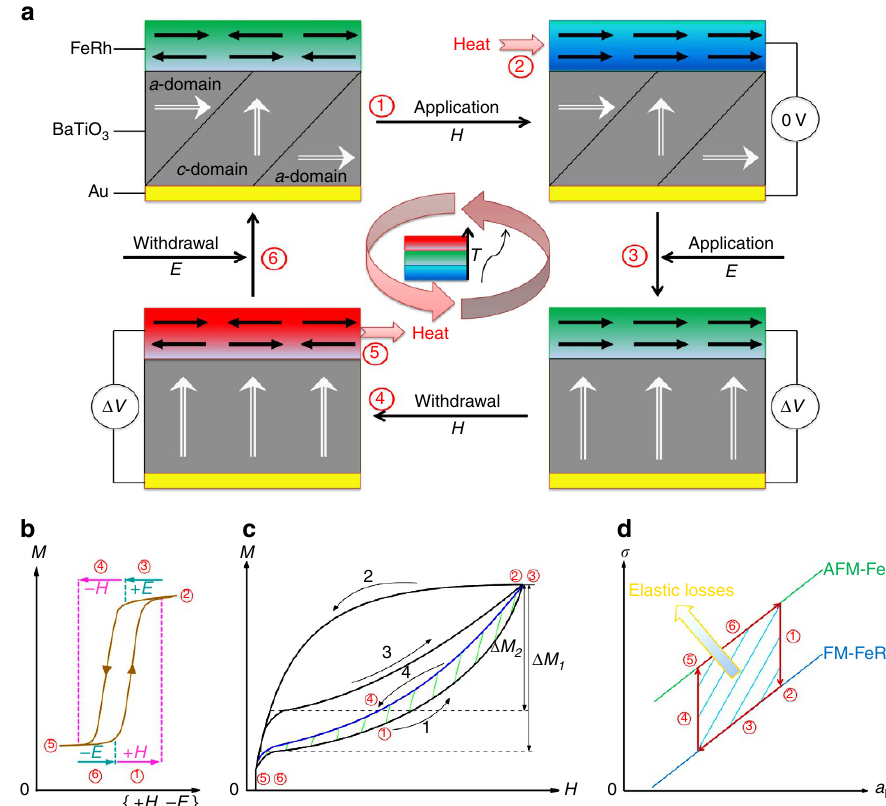
Figure 1 | Multicaloric refrigeration cycle. ( a ) Schematic of a dual-stimulus multicaloric refrigeration cycle. ( b ) Schematic of the effect of electric and magnetic fields ( E , H ) on the magnetization M of FeRh. The electric field overcomes the hysteresis, but does not itself cause M to change. ( c ) Schematic of magnetic cycles, in the space of magnetization M versus magnetic field H . The blue curve denotes a path followed in the presence of the electric field. Black uncircled numbers refer to measurement paths described in the main text. ( d ) Schematic of elastic losses, in the space of biaxial thin film stress s versus average in-plane lattice constant of FeRh a IP . In a – d , the red circled numbers 1–6 correspond to the steps described in the main text, and in b – d arrows indicate the sequence of proposed